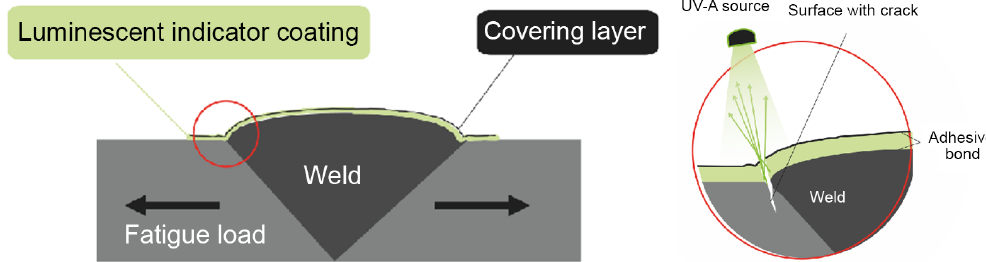
Figure 1. Intact crack luminescence coating at a welding seam (left) and the emission of light under UV-A radiation when a crack occurs (right) (M.